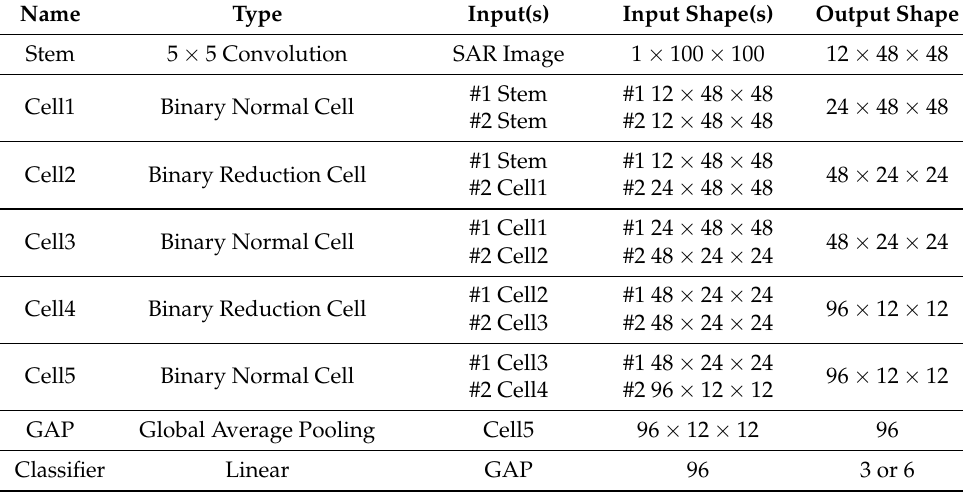
Table 1. The details of SBNN network